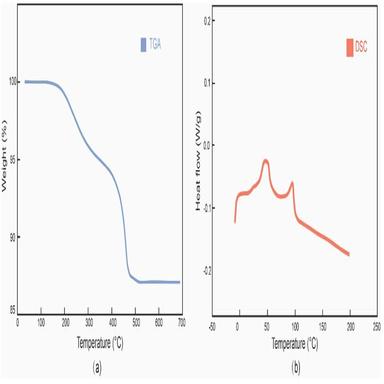
Thermal properties of binder-coated zirconia feedstock: (a) thermogravimetric analysis results, (b) differential scanning calorimetry results (second heating scan).